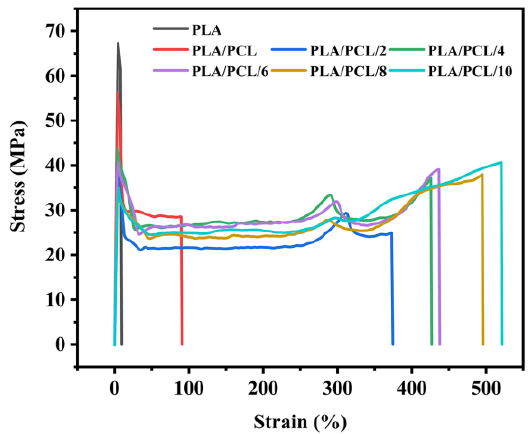
Figure 8. Tensile stress-strain curves of the neat PLA, PLA/PCL and PLA/PCL/EMA-GMA blends.